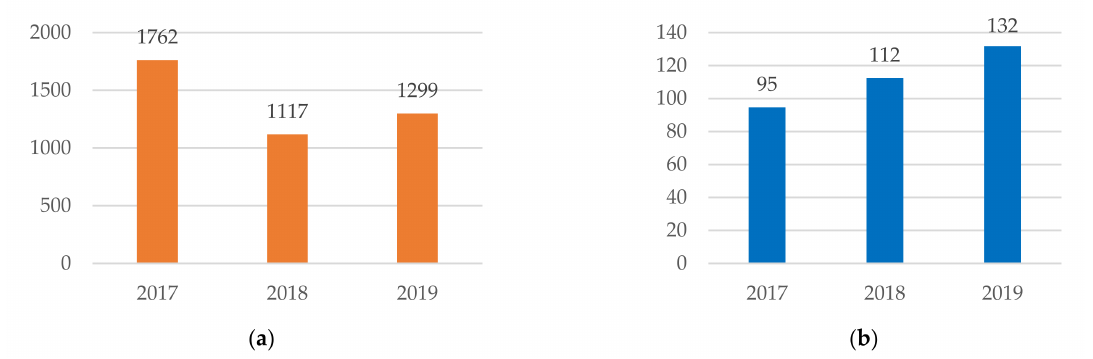
Figure 1. ( a ) Production sold (in thousand tonnes) of beet-pulp, bagasse and other waste of sugar manufacturing in Poland. ( b ) Production sold (million PLN) of beet-pulp, bagasse and other waste of sugar manufacturing in Poland. Own elaboration based on: